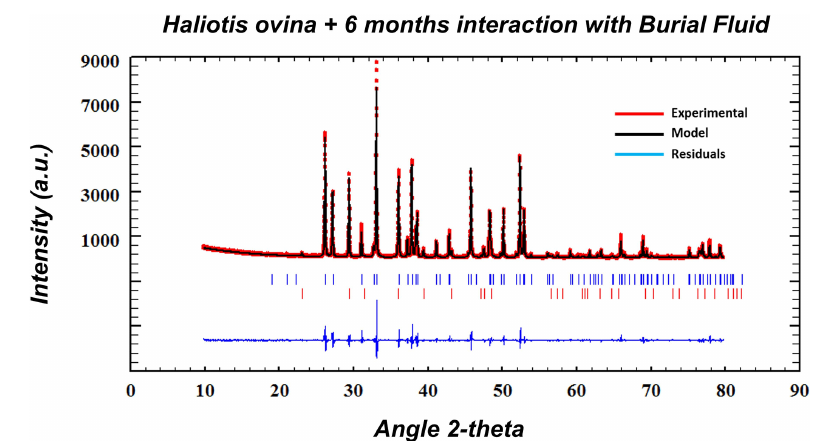
Figure A14. Exemplary Rietveld refinement plot for an altered Haliotis ovina sample (6 months, 80 ◦ C in Mg-rich fluid). Red dots: data points; black line: calculated XRD profile; bottom blue line: difference between observed and calculated data; blue vertical bars: positions of aragonite diffraction peaks; red vertical bars: position of calcite diffraction